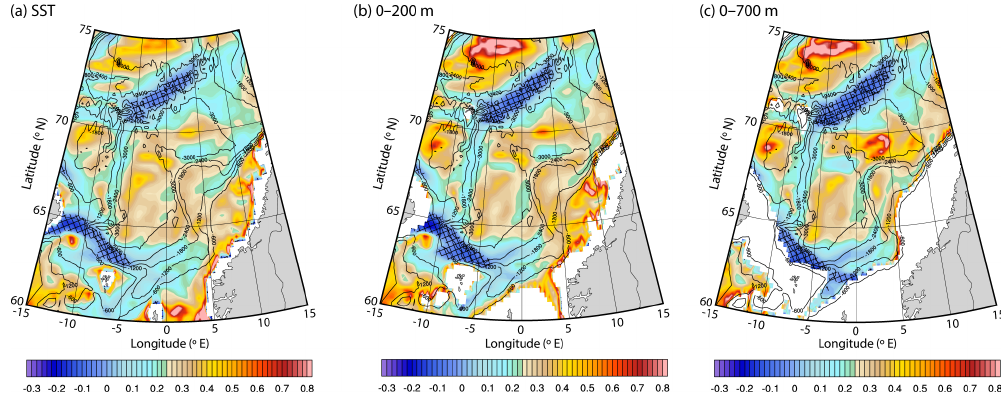
Figure 5. Singularity exponents estimated from TOPAZ (a) SST, (b) upper 200m and (c) upper 700m depth averaged potential temperature for the time period 1991–2015. Black isobaths are drawn for every 600m. Regions shallower than 200 and 700m are masked respectively in panels (b) and (c) . Negative values are highlighted (black